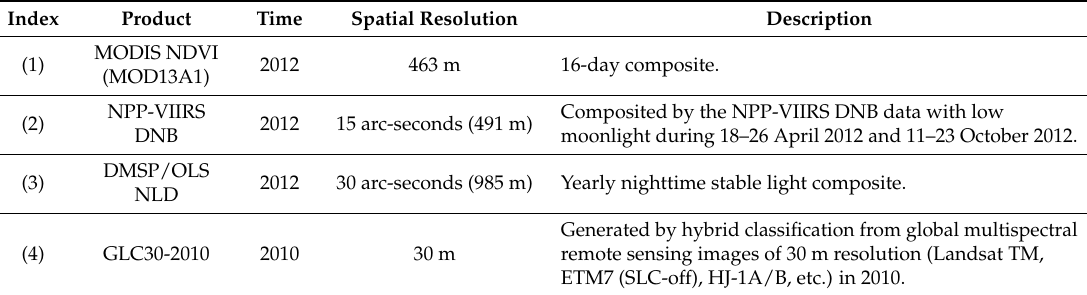
Table 1. Descriptions of the data used in this